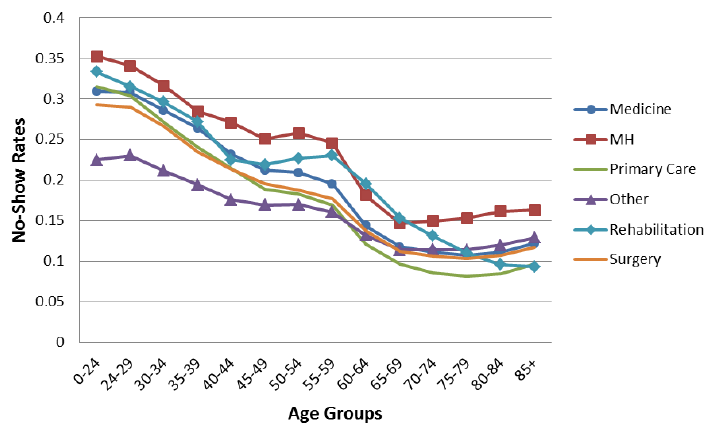
Figure 3. No-show rates for male patients by age groups separated by service line.